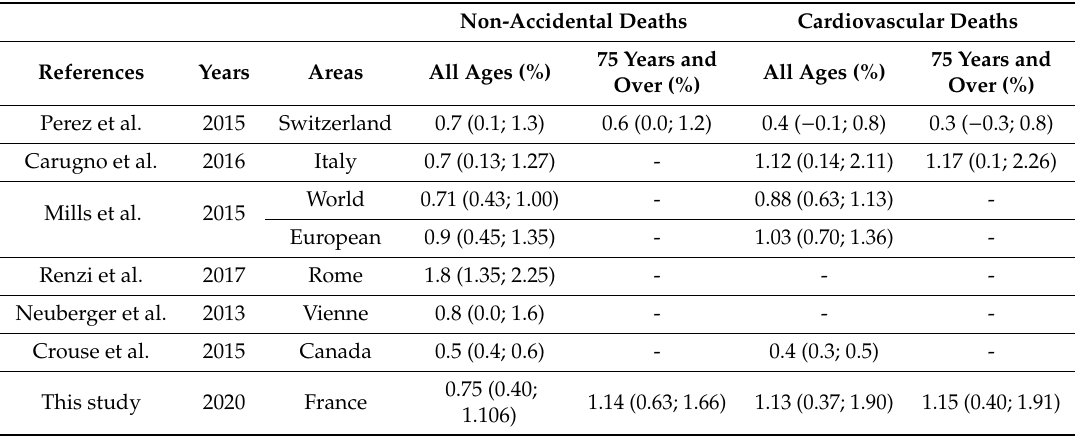
Table 5. Excess relative risk (ERR) and 95% confidence intervals (95% CI) of non-accidental